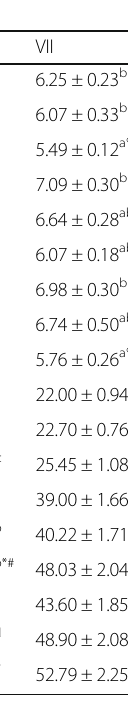
Table 2 The levels of malondialdehyde (MDA) and glutathione (GSH), after 1, 7, and 14 days in the brain, liver, and kidneys of control rats (I), and those administered 0.5 g and 1.0 g of NiO-NPs (II and III), 0.5 g and 1.0 g of Co 3 O 4 -NPs (IV and V,) as well as mixtures of NiO-NPs + Co 3 O 4 -NPs (0.25 g + 0.25 g, VI) and (0.5 g + 0.5 g, VII) per kilogram body weight,